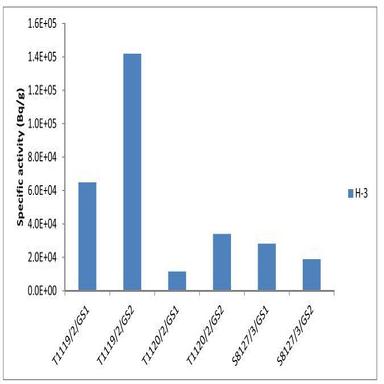
H-3 specific activity in the AGR graphite fuel sleeve samples. Fig. 7. Gamma spectrometry data for the AGR graphite sleeve samples.